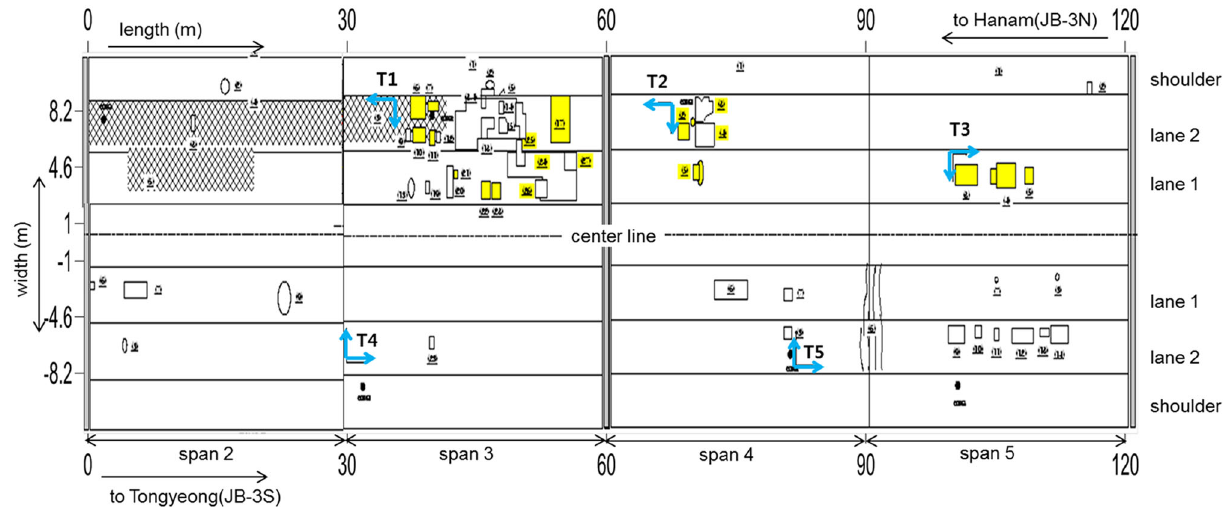
Fig. 11 Condition map of concrete bridge deck obtained from visual inspection. ( * : one way cracks, filled square: map cracks, open circle: spalling, open square: repaired by concrete patch. : repaired by epoxy patch, : half-cell potential measurement).